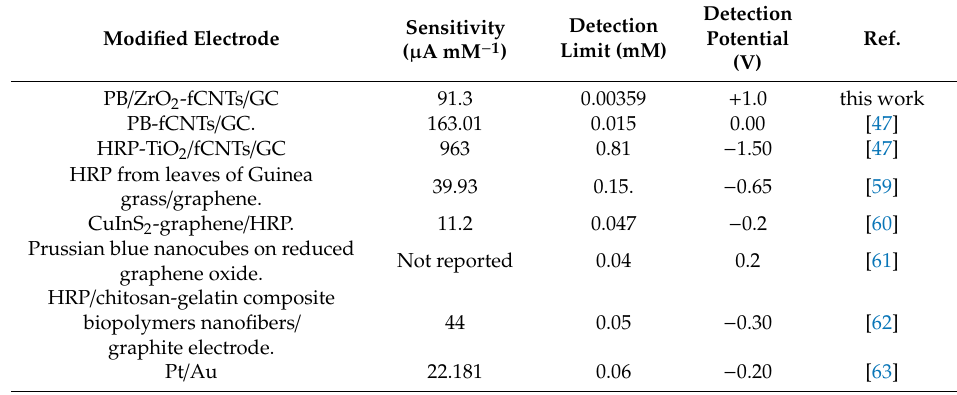
Table 6. Comparison of the results obtained at modified electrodes with other electrode reported in the literature.